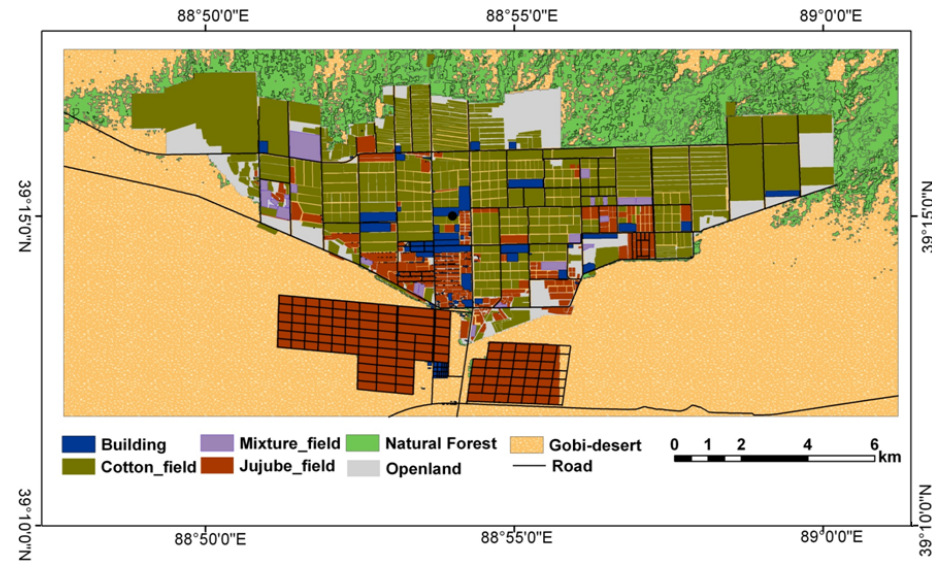
Figure 3. 2011 map of land-cover types of Milan oasis as derived from satellite images (Quickbird, Landsat ETM + , see Sect. 2.2.5).